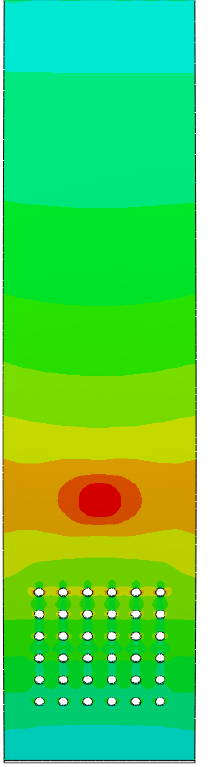
Fig. 9 Results of numerical simulations. Maximum principal stress contours in the case of static loading.